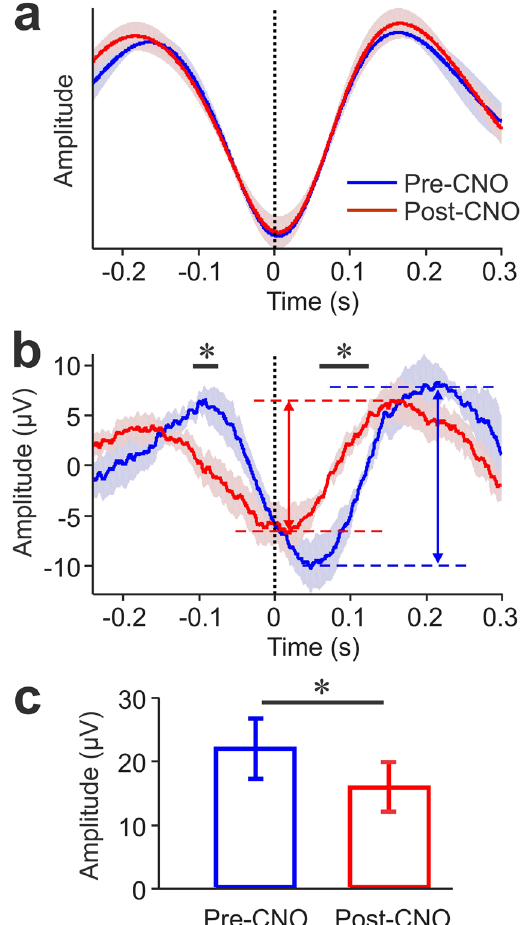
Figure 4. Changes in respiration and local field potential (LFP) recorded in hippocampal CA1 region following Clozapine N-oxide (CNO) injection in DREADD-mice (n = 4). ( a ) Group-average respiratory traces before (blue) and after (red) CNO-injection aligned on the end of expiration (t = 0). ( b ) Group-average LFP traces aligned on the end of expiration before and after CNO injection. Color code as in ( a ). Horizontal black bars mark times where the two traces differ significantly (two-Sample t-test: * p < 0.05). The amplitude of respiration- locked LFP oscillations was determined by measuring the voltage differences between LFP maxima and minima before and after CNO injection (red and blue dashed horizontal lines mark maximal and minimal voltage values in the corresponding average LFP traces). Blue and red vertical double-arrows indicate peak-trough voltage differences for pre and post CNO injection measurements, respectively. ( c ) The amplitude of average respiration-locked LFP oscillations in CA1 was significantly reduced when OB bulb activity was inhibited by CNO injections. Error bars represent standard error of the mean. (Paired-t-test: * p <